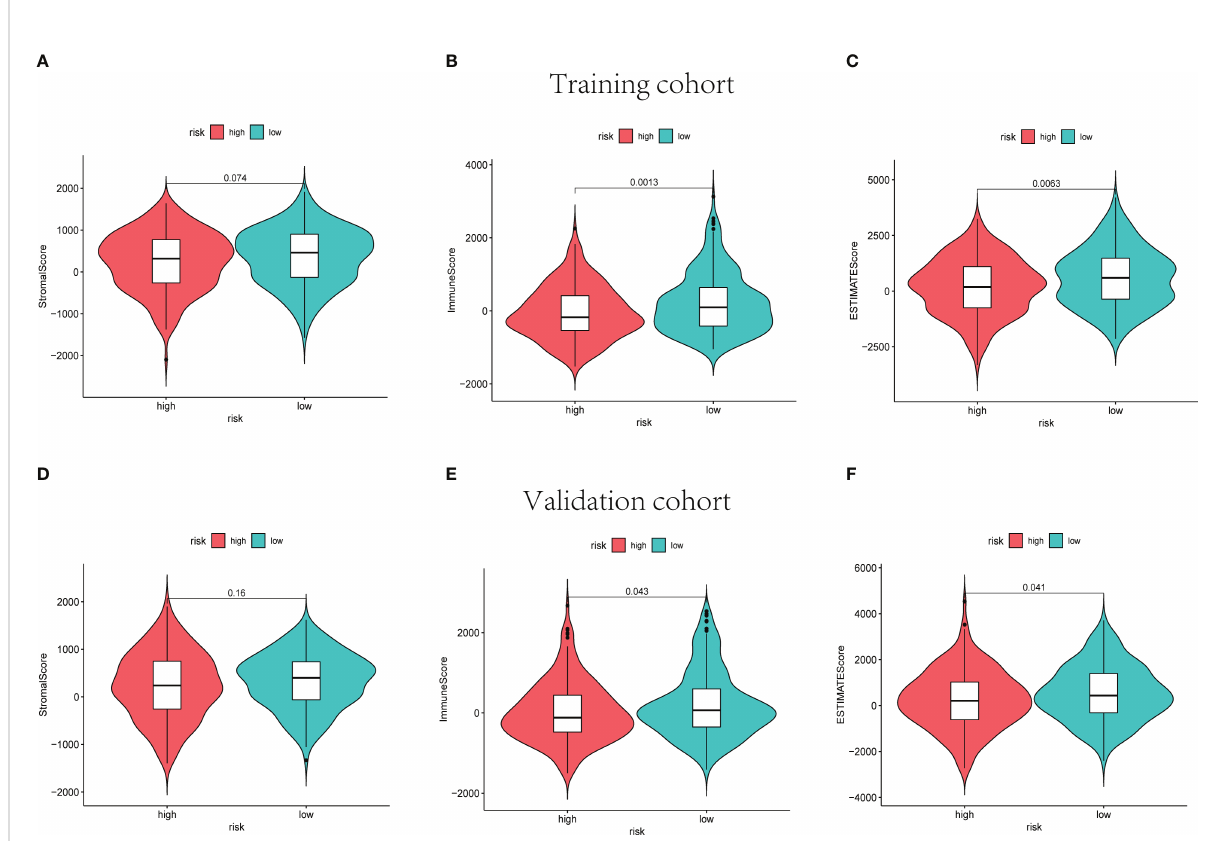
FIGURE 7 The stromal scores, immune scores, and ESTIMATE scores of high-risk and low-risk sets in training (A – C) and validation (D – F)